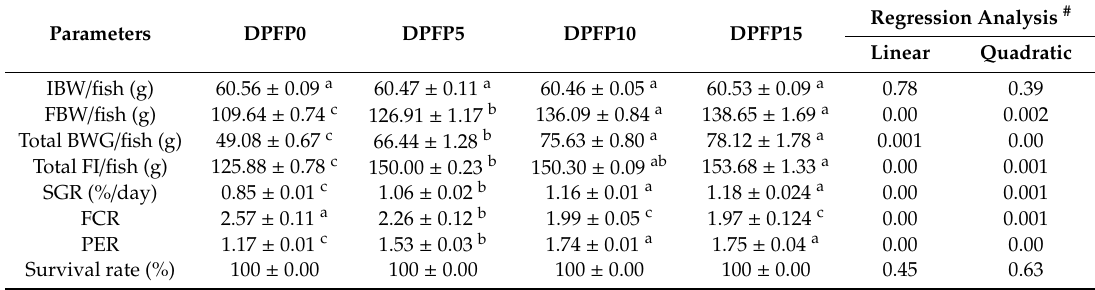
Table 2. The e ff ects of dietary doum palm fruit powder (DPFP) on the growth performance and survival rate of African